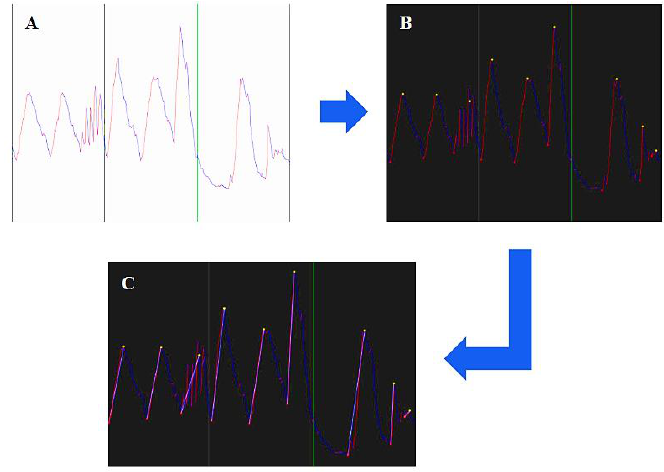
Figure 4. Raw data extraction process. ( A ) 30 s of raw data (red during inhalation, blue during exhalation; ( B ) absolute maximum/minimum points found for each cycle; ( C ) vector representation of the inhalation phase.